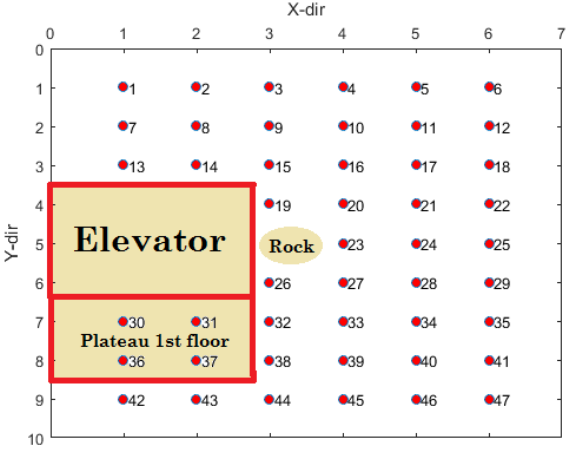
Figure 6. The measurement locations (red dots) in the test